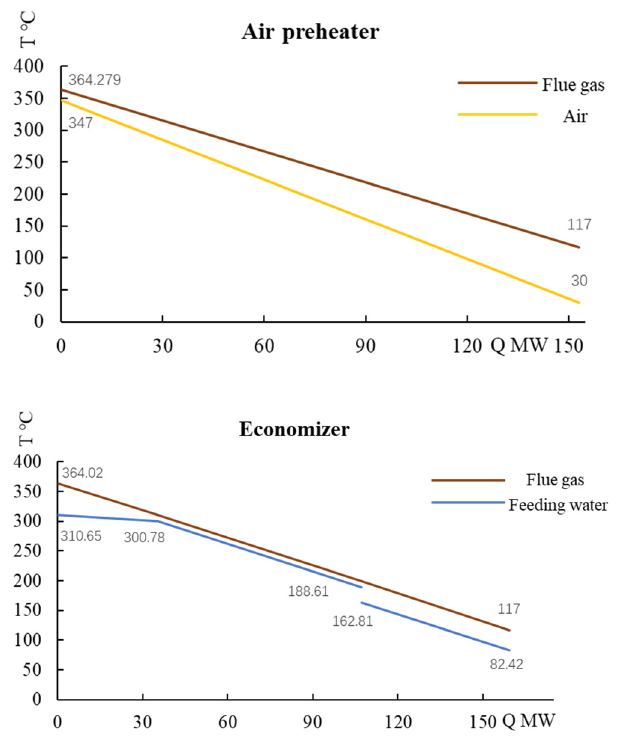
Figure 9. Heat transfer analysis of the tail flue in new system 2.